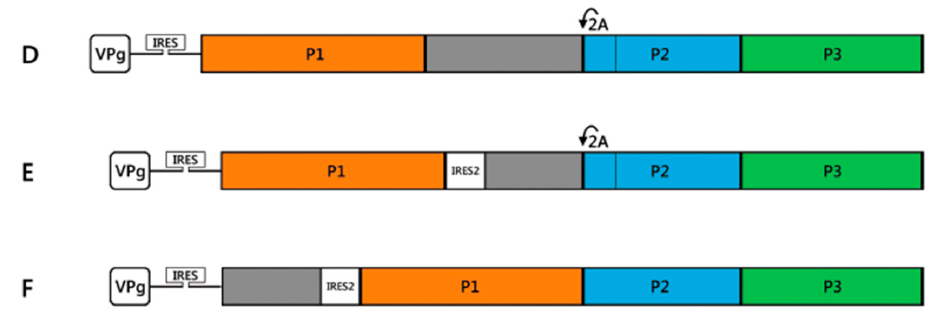
Figure 2. The genetic structure of enterovirus expression vectors. ( A ) Schematic representation of the enterovirus genome (drawn in the scale except for the internal ribosomal entry site (IRES) region and the inserts); the conserved and highly-structured 5 ′ - and 3 ′ -untranslated regions (UTRs) are indicated and the major proteolytic products of the viral polyprotein (P1, P2, and P3) are outlined by colored boxes. The 5 ′ -end of the genome is covalently bound by viral genome-linked protein, VPg and 5 ′ -UTR contains an IRES for cap-independent translation. The 3 ′ -UTR contains a short polyA tail (pA); ( B ) Epitope display vectors contain short foreign inserts to display epitopes (in grey) within the P1 structural protein-encoding region; ( C , D ) Protein expression vectors. Foreign sequences fused to the viral ORF at its 5 ′ -end or between the coding regions for P1 and P2. Artificial proteolytic cleavage sites for the viral 2A pr ° and/or 3C pr ° proteases (indicated by curved arrows) are used for proteolytic processing of the fusion polyprotein; ( E , F ) Dicistronic vectors. Foreign inserts placed under the control of a secondary IRES element (IRES2) (originating from a related picornavirus) between P1 and P2. Alternatively, the upstream cistron is formed by the foreign insert driven by the original IRES, and the viral polyprotein is expressed under the control of the IRES2.